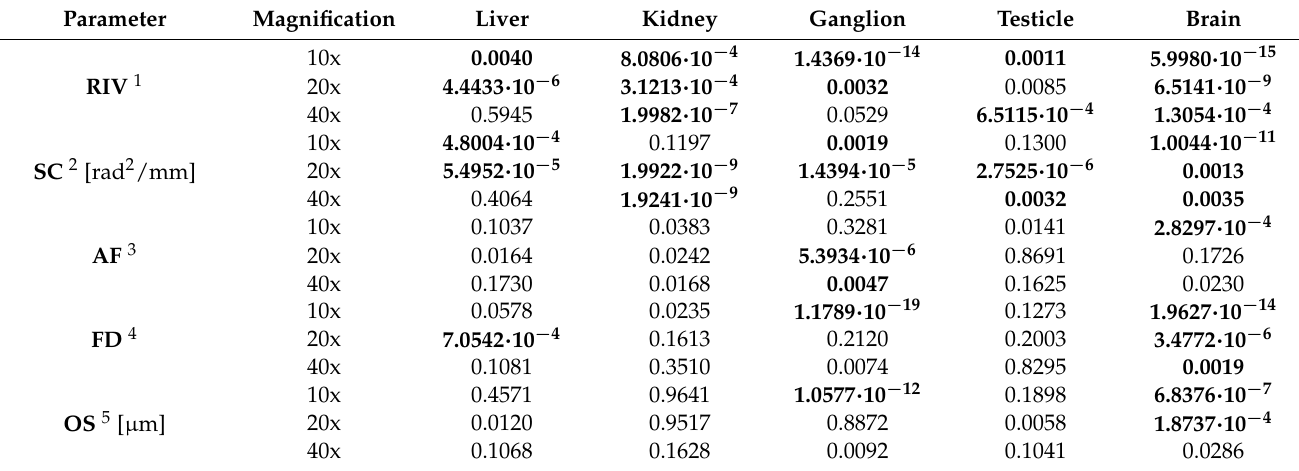
Table 2. Results of the ANOVA analysis for each tissue type, magnification and phase-contrast parameter. The p -value of the test is shown. p -values below 0.005 are marked in bold. Parameter